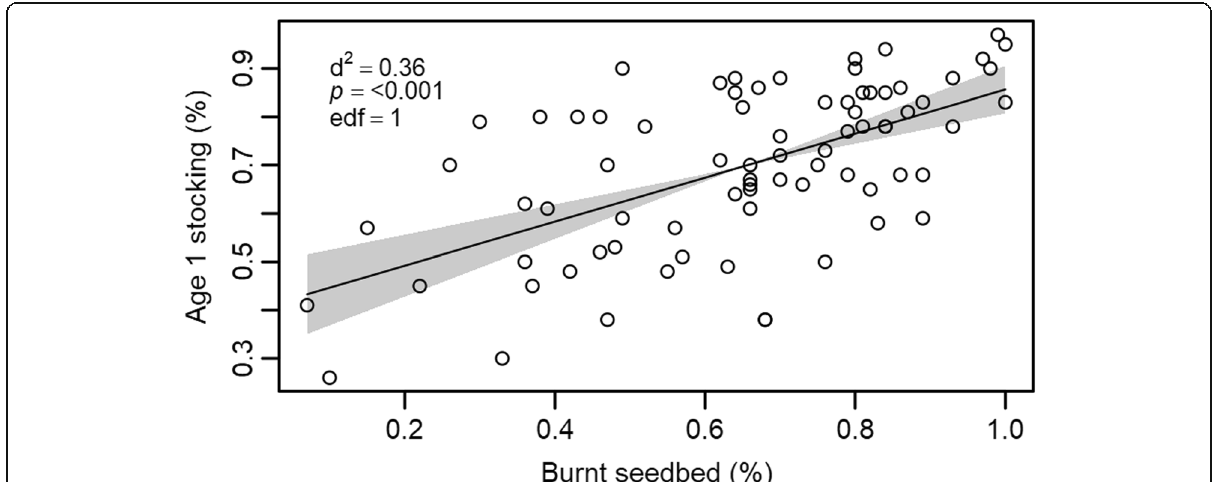
Fig. 8 Results of a generalized additive model of the relationship between eucalypt stocking at age 1 year and burnt seedbed in ARN coupes ( n = 76). The model has simplified to a linear model (edf = 1). Shaded areas indicate the 95% confidence interval. d 2 is the proportion of the null deviance explained by the model. p values indicate the approximate significance of the single smooth term, while edf is the estimated degrees of freedom for the smooth